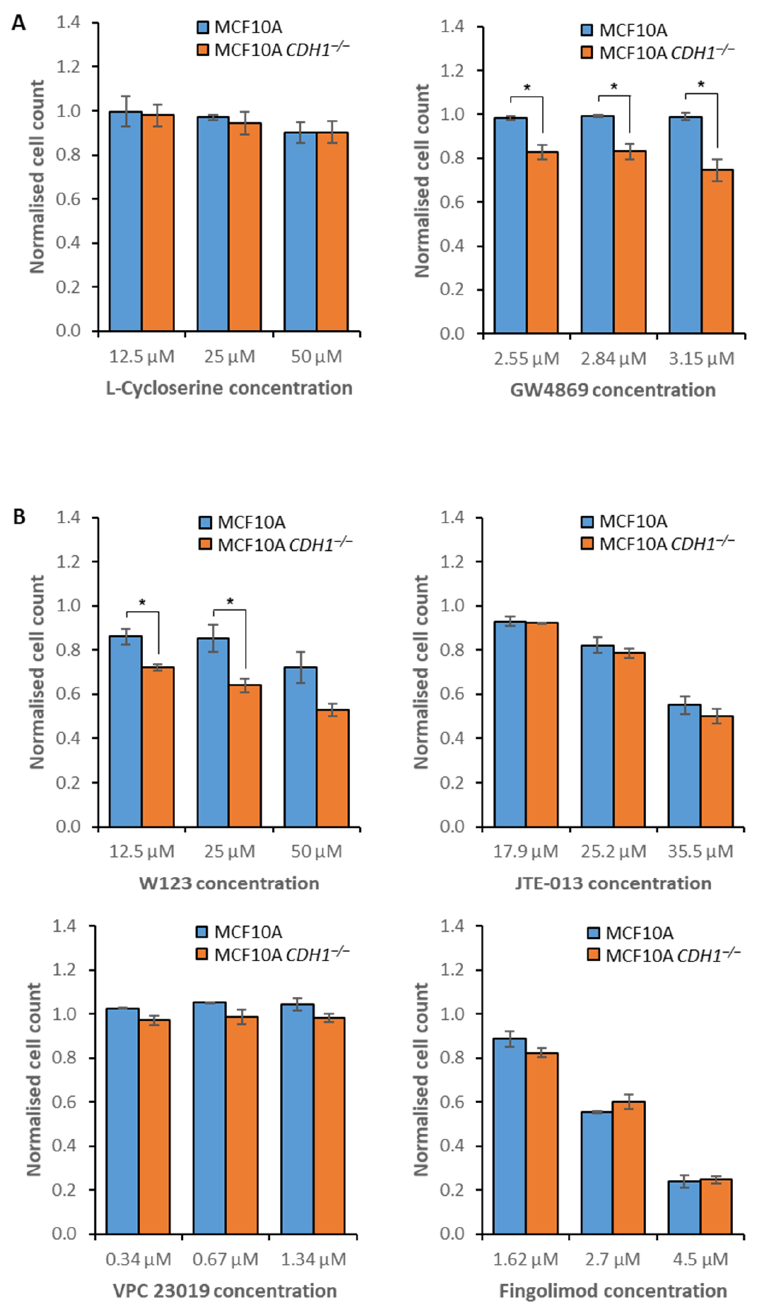
Figure 2. Efficacy of compounds inhibiting sphingolipid metabolism and signaling. MCF10A and MCF10A CDH1 − / − cells were drugged, then viability was quantified through nuclei counting, and normalization to vehicle controls. Although a nine-point serial dilution was assessed, only the three consecutive compound concentrations that exhibited the greatest difference in viability between CDH1 +/+ and CDH1 − / − cells are depicted. Where no toxicity was observed, the maximum assessed concentrations are depicted. ( A ) Cell viability following treatment with inhibitors of sphingolipid metabolism. ( B ) Cell viability following treatment with inhibitors of S1PRs. Average values were calculated from three biological replicates, with +/ − 1 standard error of the mean depicted by error bars. P -values were calculated using Student’s t -test; * p < 0.05.